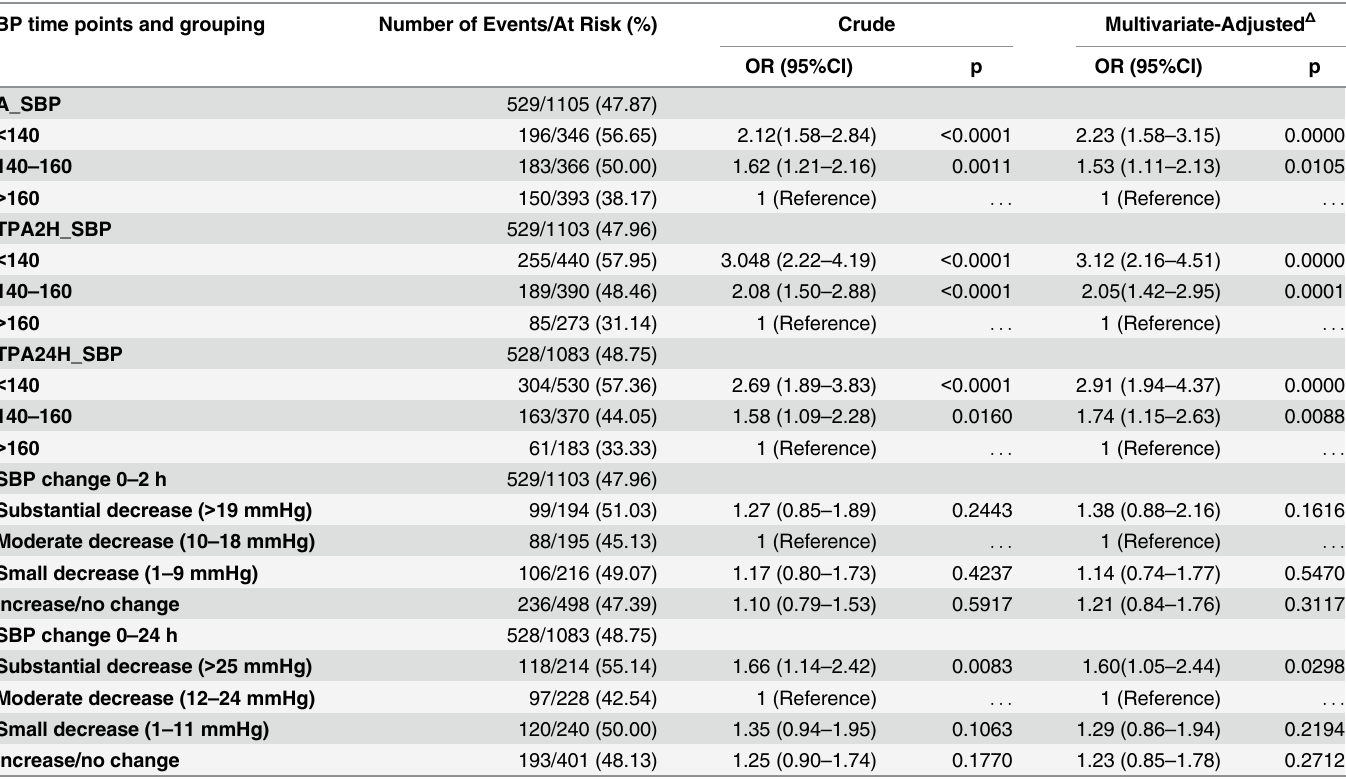
Table 3. BP grouping of different time points & favorable outcome (mRS 0 – 1 at 90